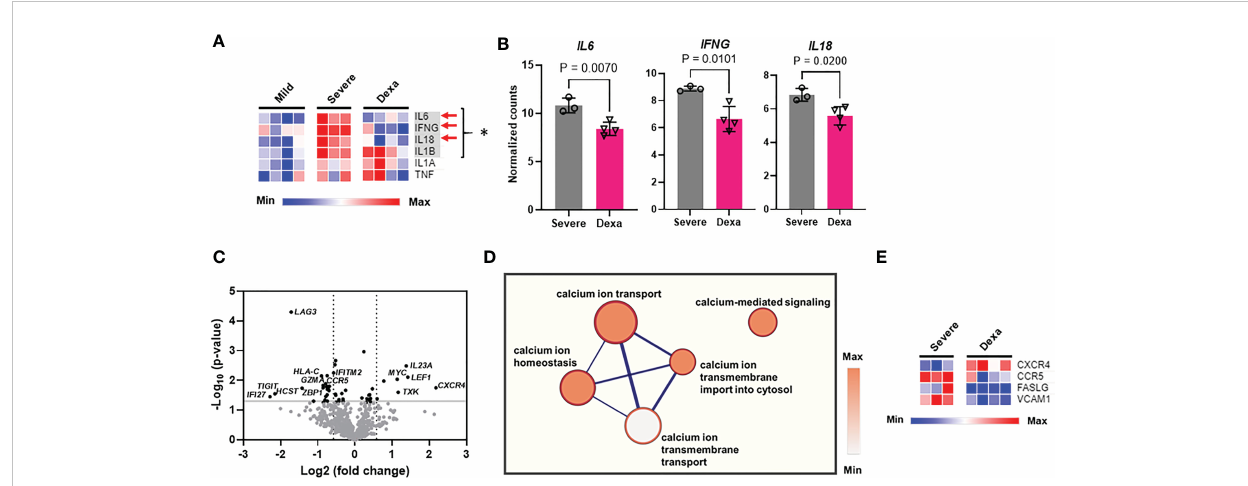
FIGURE 3 Cytokine storm gene expression, differential gene expression, and calcium signaling pathways altered by dexamethasone in severe COVID-19. (A) Heatmap depicting expression levels (determined as normalized RNA counts by NanoString) of genes involved in cytokine storm production in PBMCs from patients with mild (n=4), severe COVID-19 (Severe, n=3), and severe COVID-19 treated with dexamethasone (Dexa, n=4). Signi fi cantly altered genes between mild and severe groups are highlighted in gray and represented by *, and those altered between severe +/- dexamethasone are marked by red arrows. (B) Cytokine storm genes signi fi cantly altered by dexamethasone treatment in severe COVID-19 patients. Bars represent means ± SD, and each symbol represents an individual. Signi fi cance in (A, B) was determined by unpaired t-test. (C) Volcano plot showing differentially expressed genes (P<0.05 with unpaired t test, -log 10 Pvalue > 1.3, fold change>1.5) altered by dexamethasone in severe COVID-19. Top differentially expressed genes are labeled. (D) Correlation network analysis for calcium signaling-related pathways that were decreased by dexamethasone in severe COVID-19. The cluster of nodes that represent the transmembrane calcium ion transport are grouped together in the outer rectangle. Thicker edges (blue lines) indicate the number of genes shared between the nodes, whereas the intensity of the node fi ll color indicates the enrichment of genes in that speci fi c process. (E) Heatmap depicting expression levels (determined as normalized RNA counts by NanoString) of signi fi cantly altered genes, that were involved in the calcium signaling-related pathways (shown in Panel D ) in PBMCs from patients with severe COVID-19 (Severe, n=3), and severe COVID-19 treated with dexamethasone (Dexa, n=4). Further details and p-values for these genes are presented in Table S5. Signi fi cance determined by unpaired t-test.